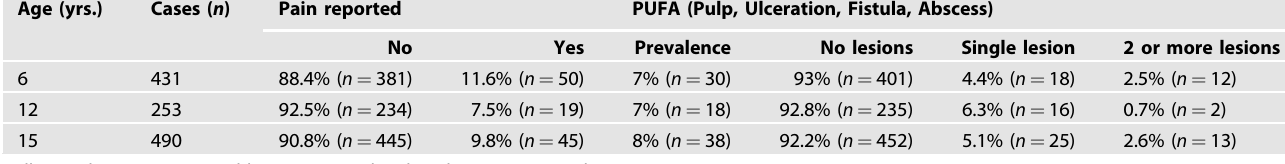
Table 3. Prevalence of pain in teeth and PUFA lesions seen in school children in SL, 2017 ( n = 1174). Age (yrs.) Cases ( n